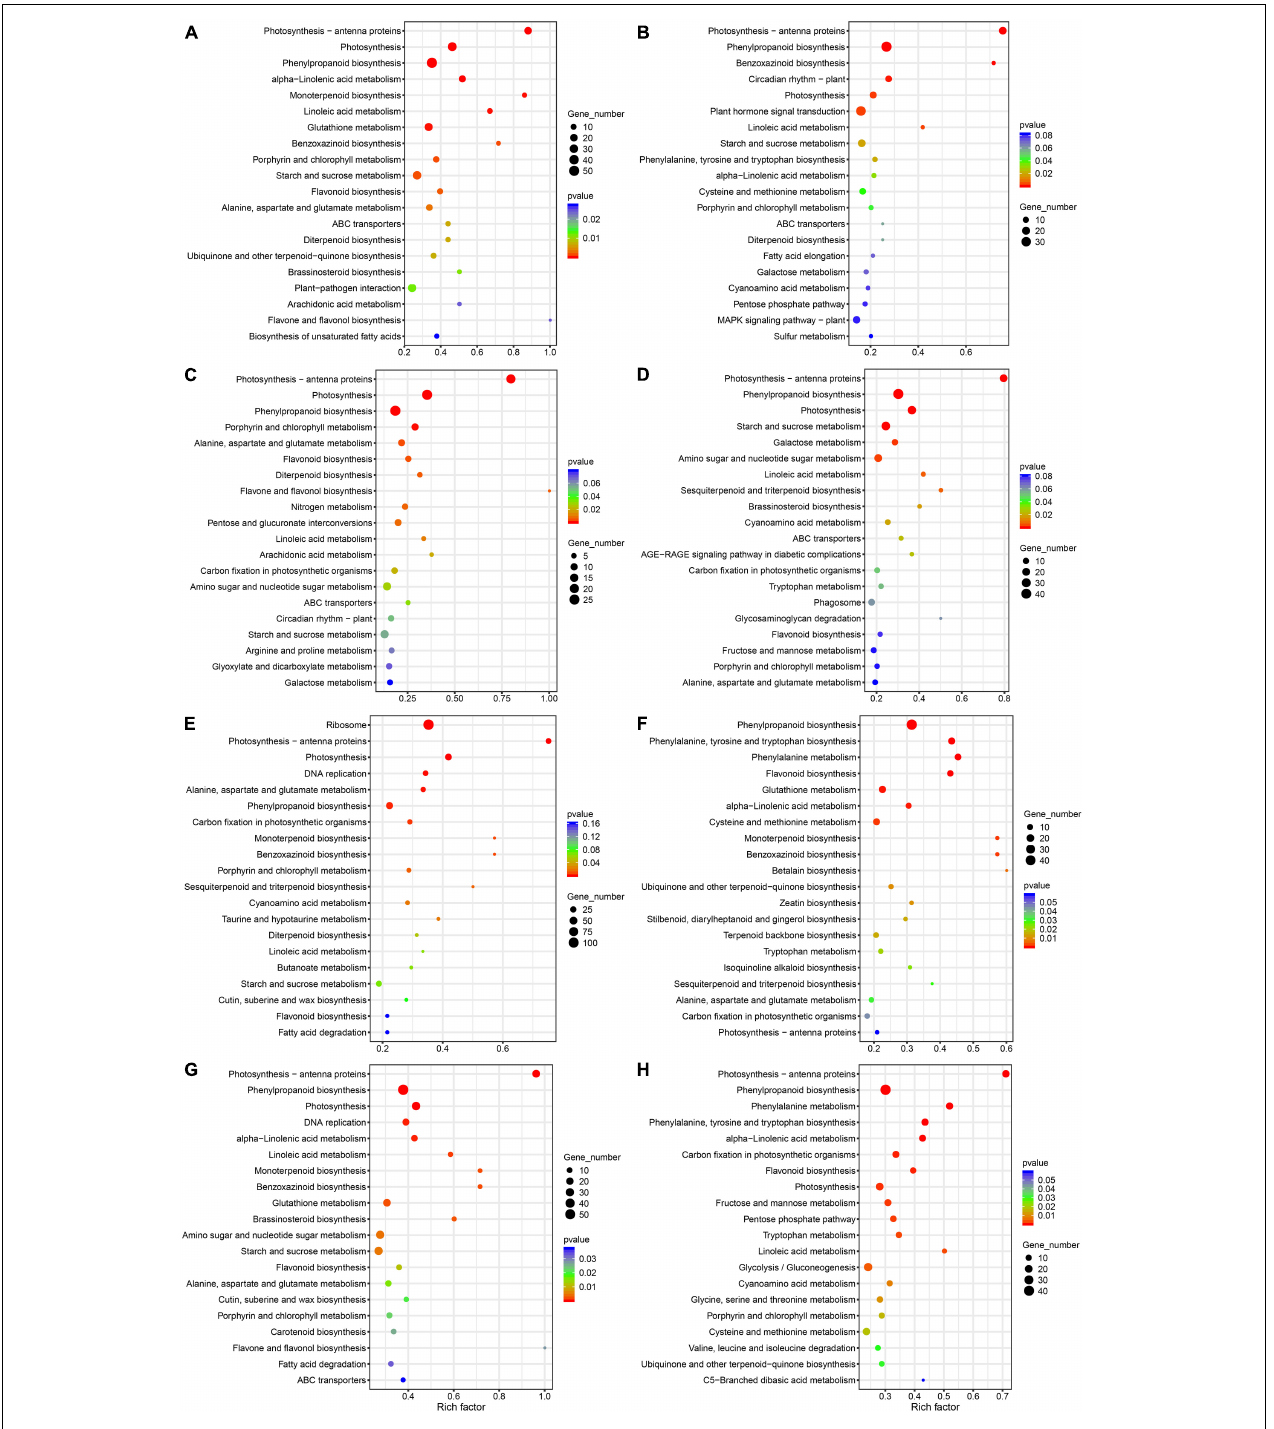
FIGURE 4 | KEGG analysis of DEGs in different comparison groups. (A) QDS vs. QCK; (B) ZDS vs. ZCK; (C) QDSGA vs. QCKGA; (D) QDSGA vs. ZDGA; (E) QDSBR vs. QCKBR; (F) ZDSR vs. ZDBR; (G) QDSSL vs. QCKSL; (H) ZDSSL vs.